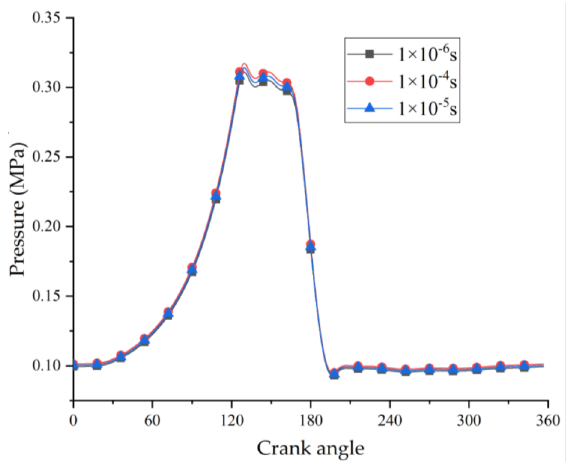
Figure 8. The cylinder pressure variation at different time